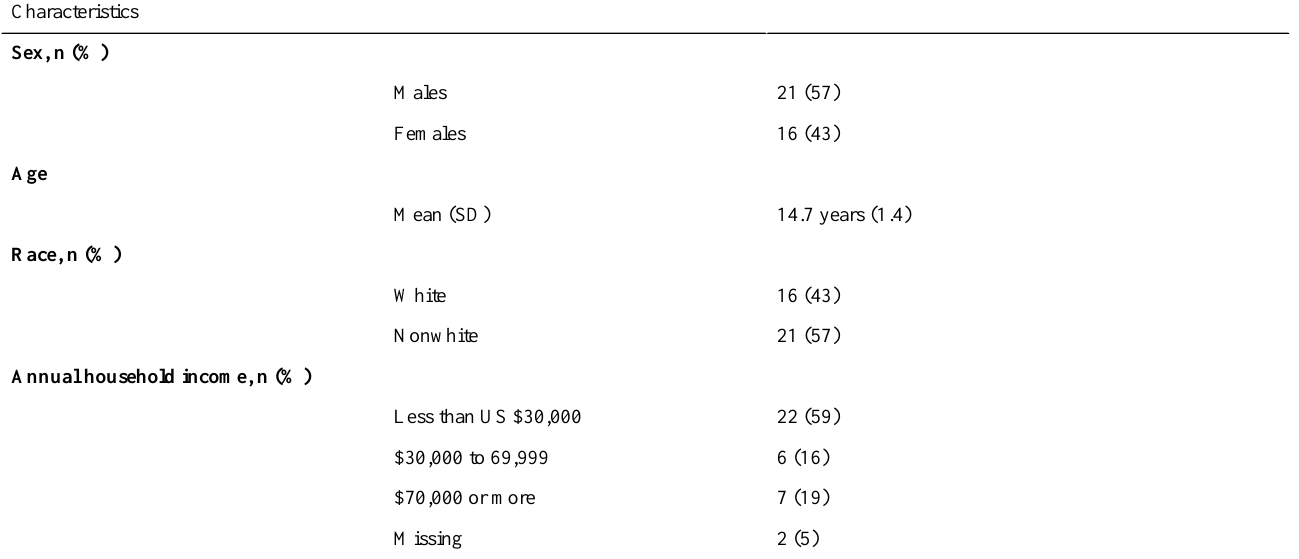
Table 1. The demographic characteristics of the sample in Phase 1 (n=37).